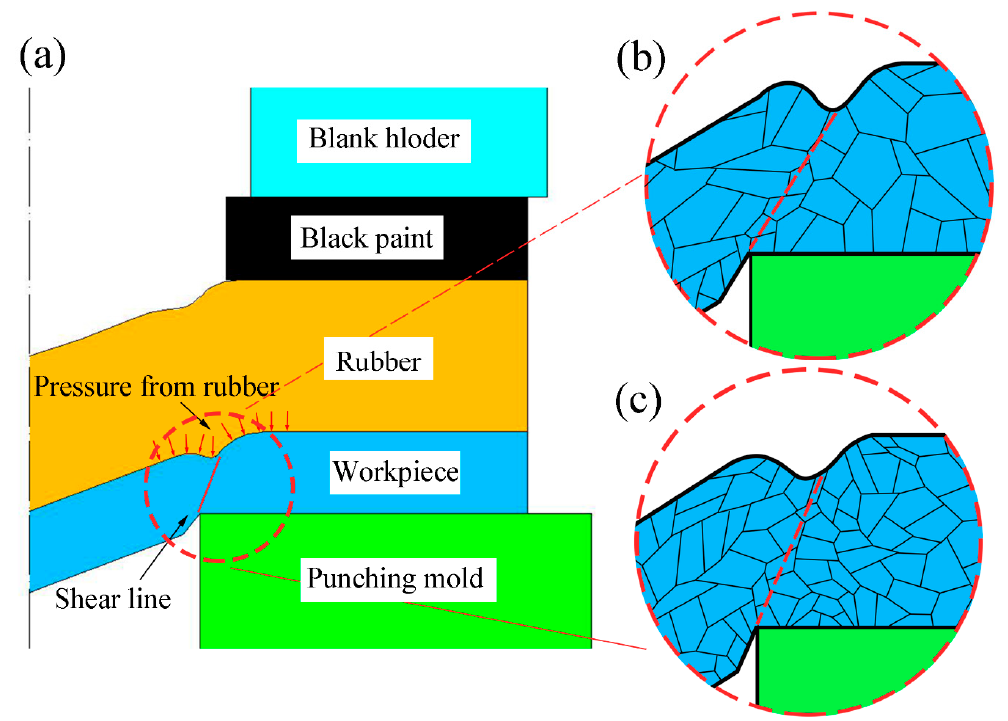
Figure 16. Deformation behavior of the workpiece during laser dynamic flexible micropunching and the influence of LPS on the dimensional accuracy of punched holes. ( a ) Schematic of deformation behavior; ( b ) copper foil without LPS; ( c ) copper foil with LPS.